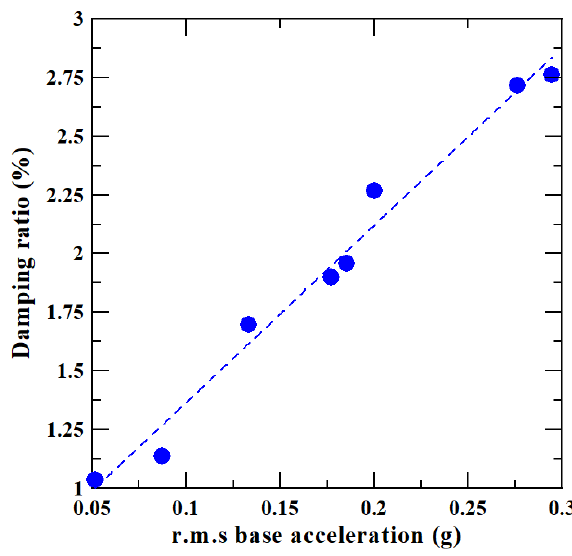
Figure 9: Damping ratio of the tube subjected to varying excitation